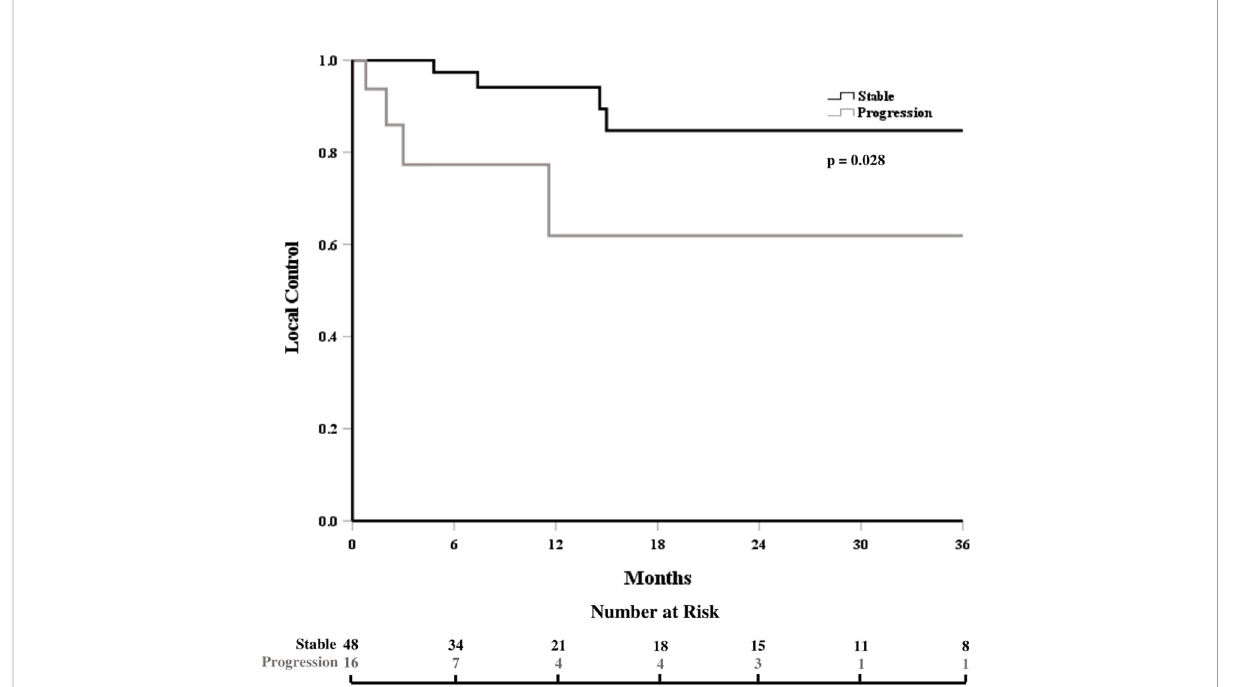
FIGURE 2 Local control, strati fi ed by degree of systemic disease control at the time of treatment.